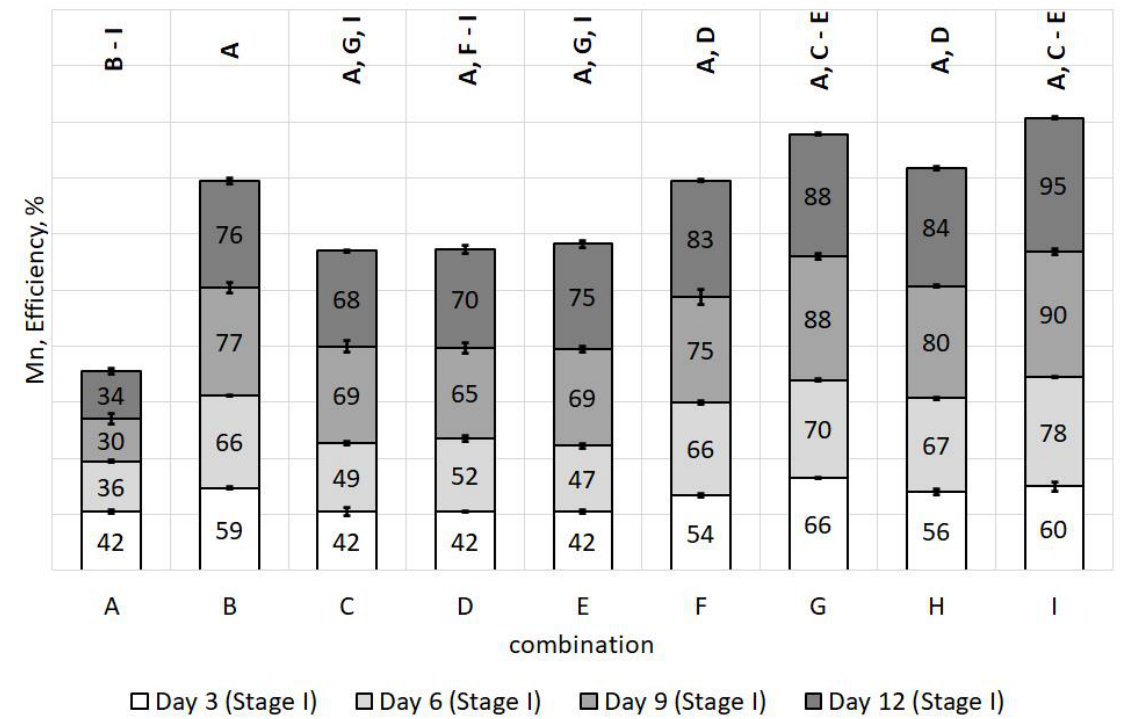
Figure 17. Effectiveness of Mn release to the dissolved fraction of leachate (Stage I).